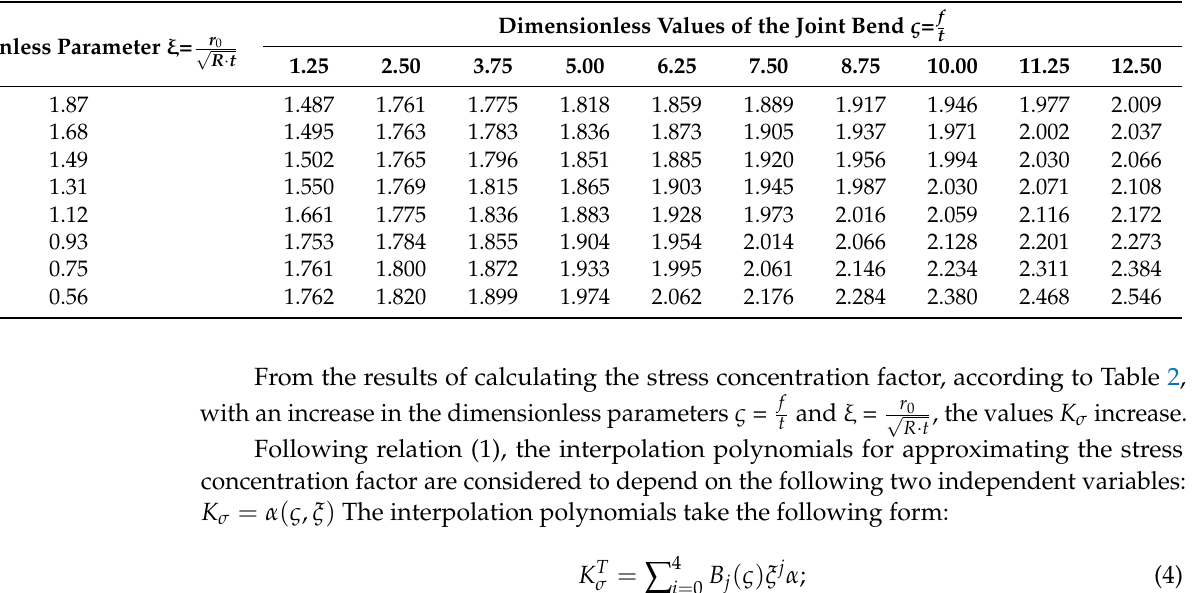
Table 2. The stress concentration factor K σ calculation results in the cylindrical tank wall field joint imperfection zone